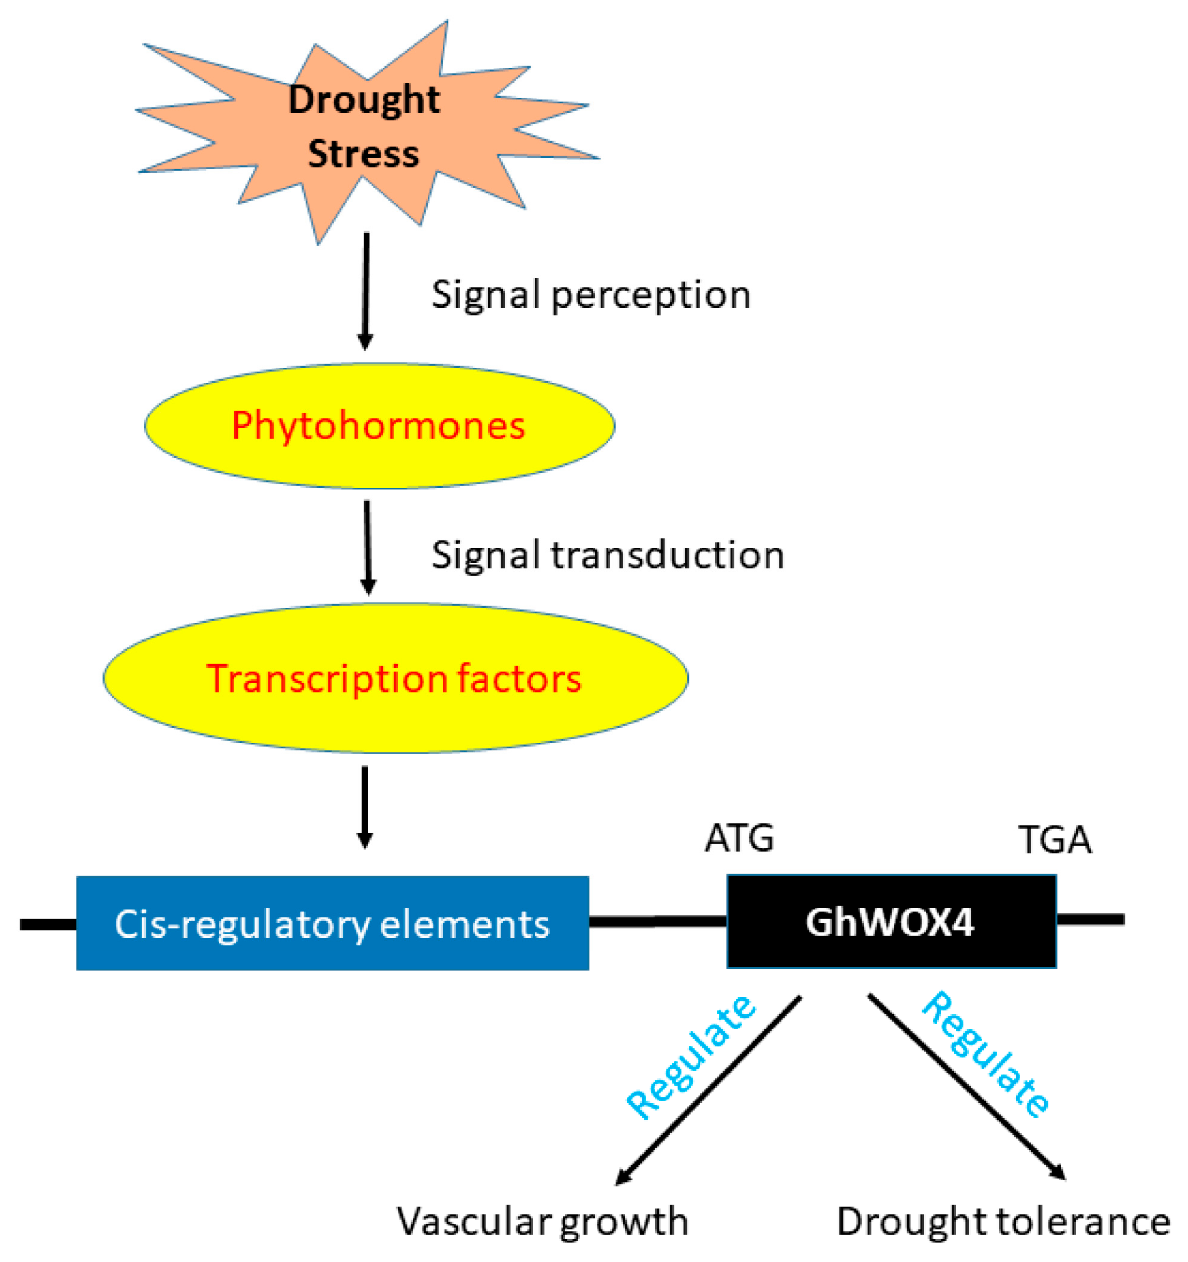
Figure 10. Model for GhWOX4 function in cotton, regulating drought stress tolerance and vascular growth by collaborating with different CREs (cis-regulatory elements), phytohormones (auxin, ethylene, ABA, etc.) and transcription factors (MYB, MYC-bHLH, WRKY, HSF, HD, etc.). Expression of GhWOX4 enhances in drought stress by affecting vascular growth to strengthen drought stress tolerance and plants growth maintenance.